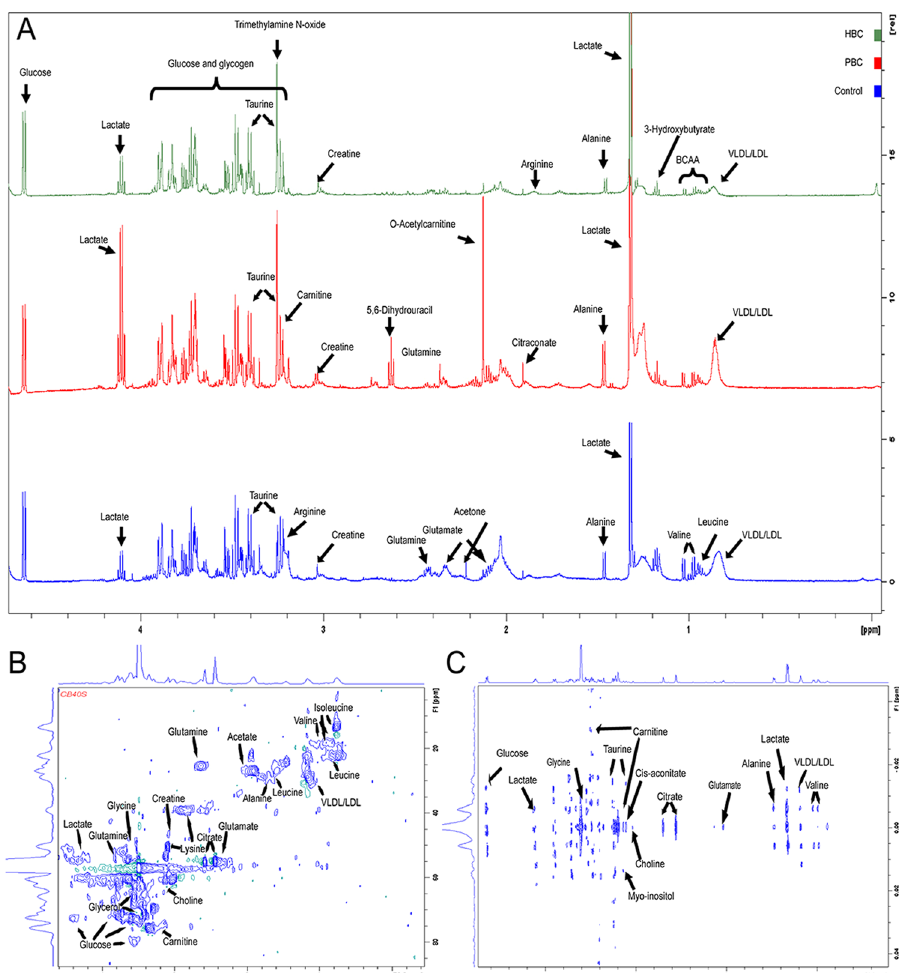
Figure 1. Typical NMR spectra of the three groups and the amplifying 2D spectra. ( A ) Metabolites were identified by representative 600 MHz NMR-based CPMG spectra. ( B and C ) 2D experiments of the HSQC and J-resolved spectra were used for the accurate identification and assignment of the metabolites in the highly crowded